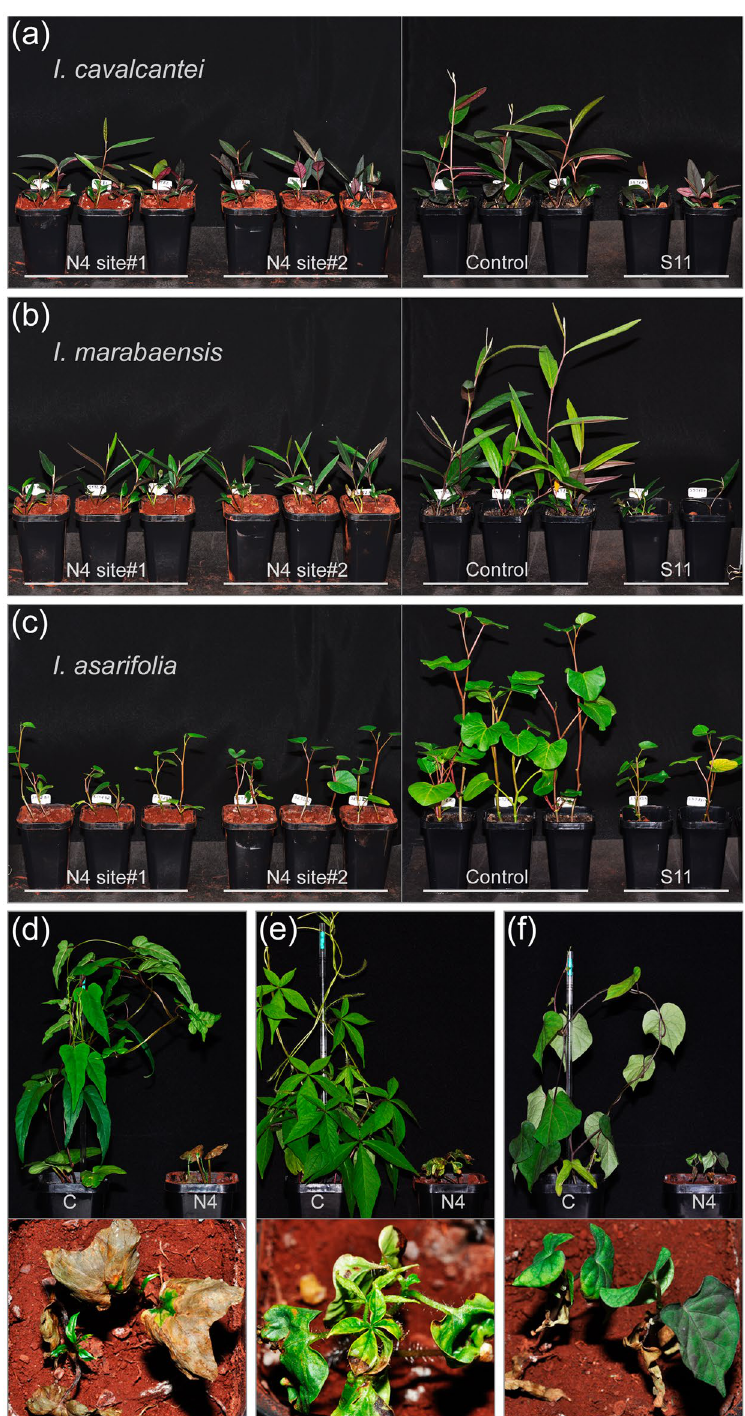
Figure 5. The growth of (a) I . cavalcantei , (b) I . marabaensis , and (c) I . asarifolia on soils collected from Canga N4 (N4 site#1, N4 site#2), S11 Plateau Canga (S11), and horticultural soil (Control). Pictures taken ten weeks after germination. Operculina hamiltonii (d) , Merremia aegyptia (e) and Ipomoea grandifolia (f) grown on horticultural soil (C) or Canga soil (N4). Seedlings grown on Canga soil (N4) were retarded, shed leaves that developed necrotic lesions (lower close up